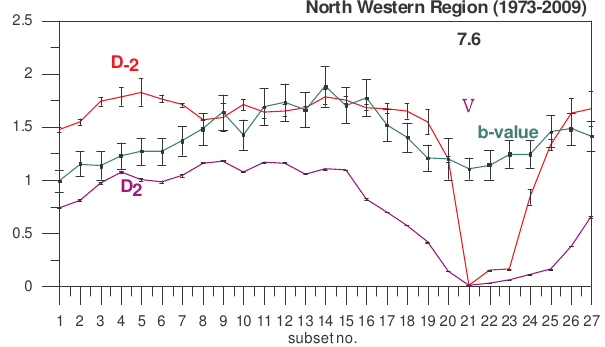
Fig. 4. The temporal variation of generalised dimension D q ( q =2, − 2) along with the temporal variation of b -value. The D q ( q =2, − 2) and b -values are shown with error